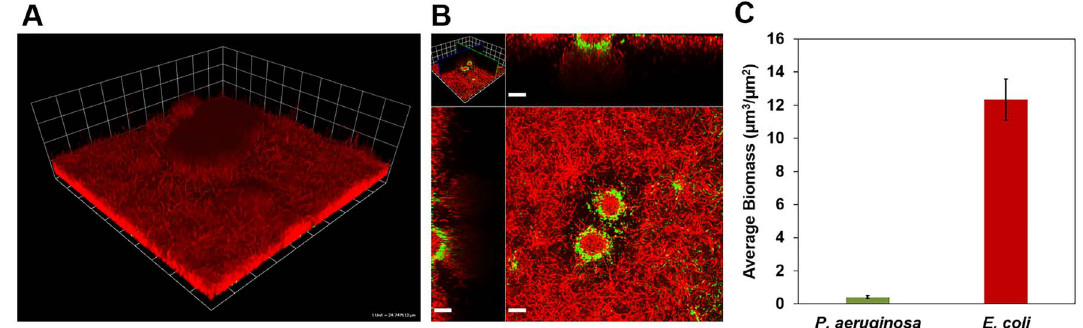
Figure 2. Co-development of E.coli and P.aeruginosa biofilms in a microfluidic flow cell and R2A medium. E. coli appears red and P. aeruginosa appears green or yellow. A) 3-day old co-inoculated P. aeruginosa - E. coli biofilm (grid unit is 23.8 m m). B) Horizontal section near the base of the biofilm and vertical sections of the biofilm shown in panel A (scale bar=20 m M). C) P. aeruginosa and E. coli biofilm biomass on day 3.